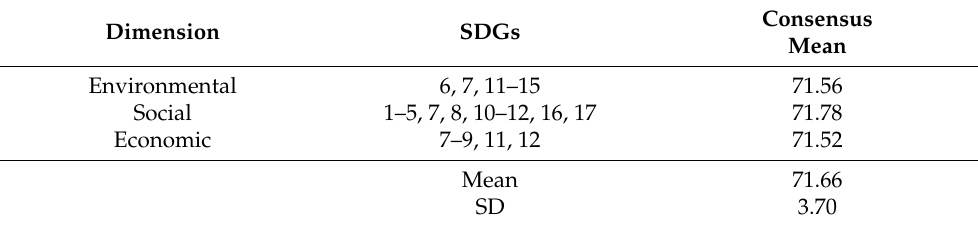
Table 12. Consensus measurement criteria.